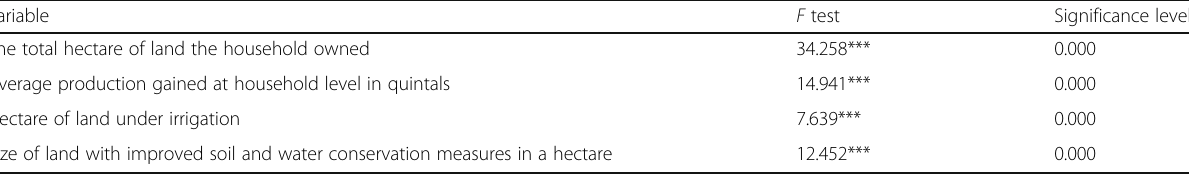
Table 3 Continuous variables considered in the ANOVA analysis for the four AESs